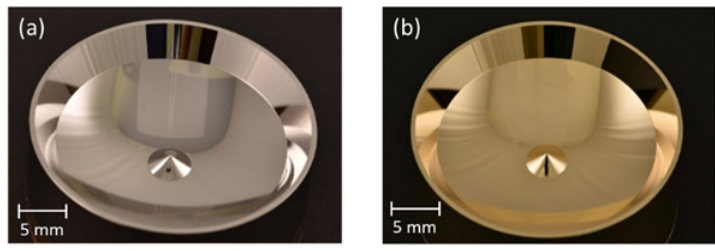
Figure 4. NiP surface of segmented reflector by ultra ‐ precision diamond turning ( a ) and after gold coating ( b ). The reflectivity increases from 53% to 95% for NIR light when adding the Au